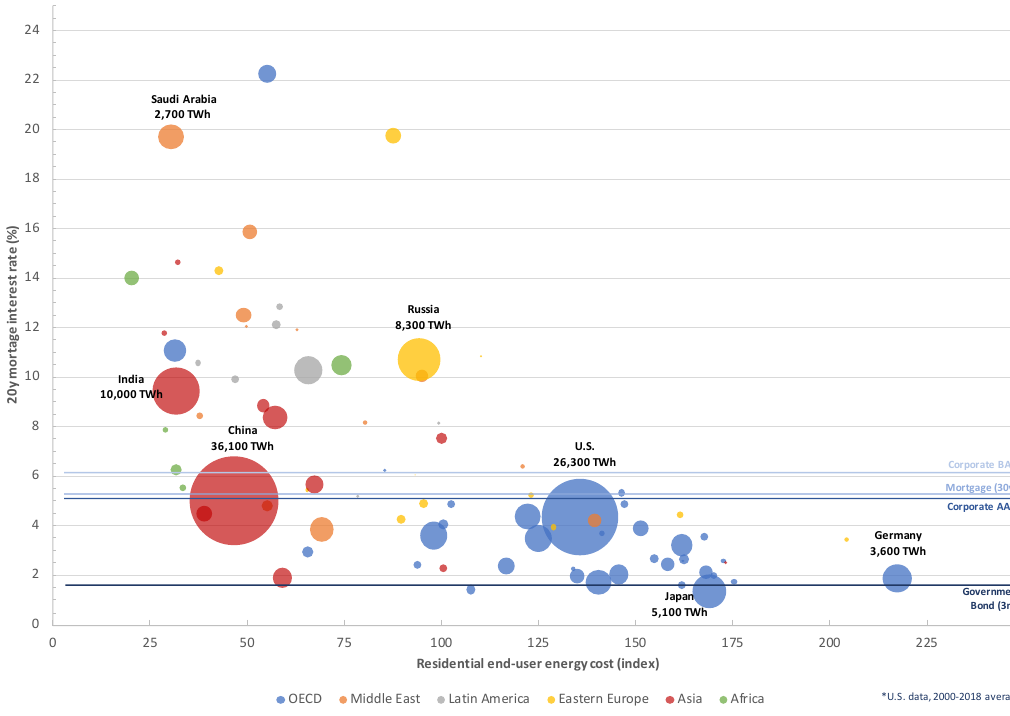
Figure 4. Techno-economic potential of real-estate-backed power purchase agreements in di ff erent countries. Bubble sizes represent total energy demand per country, and location of the bubble represents economic viability of real estate PPA, lower mortgage rates indicating lower financing costs and higher end-user energy costs indicating higher motivation for fixing energy costs. Average US data put the country-level risk and potential into perspective, government bond representing cost of finance for feed-in-tari ff s and corporate AAA representing cost of finance for a low risk corporate PPA that is nearly the same level as average US